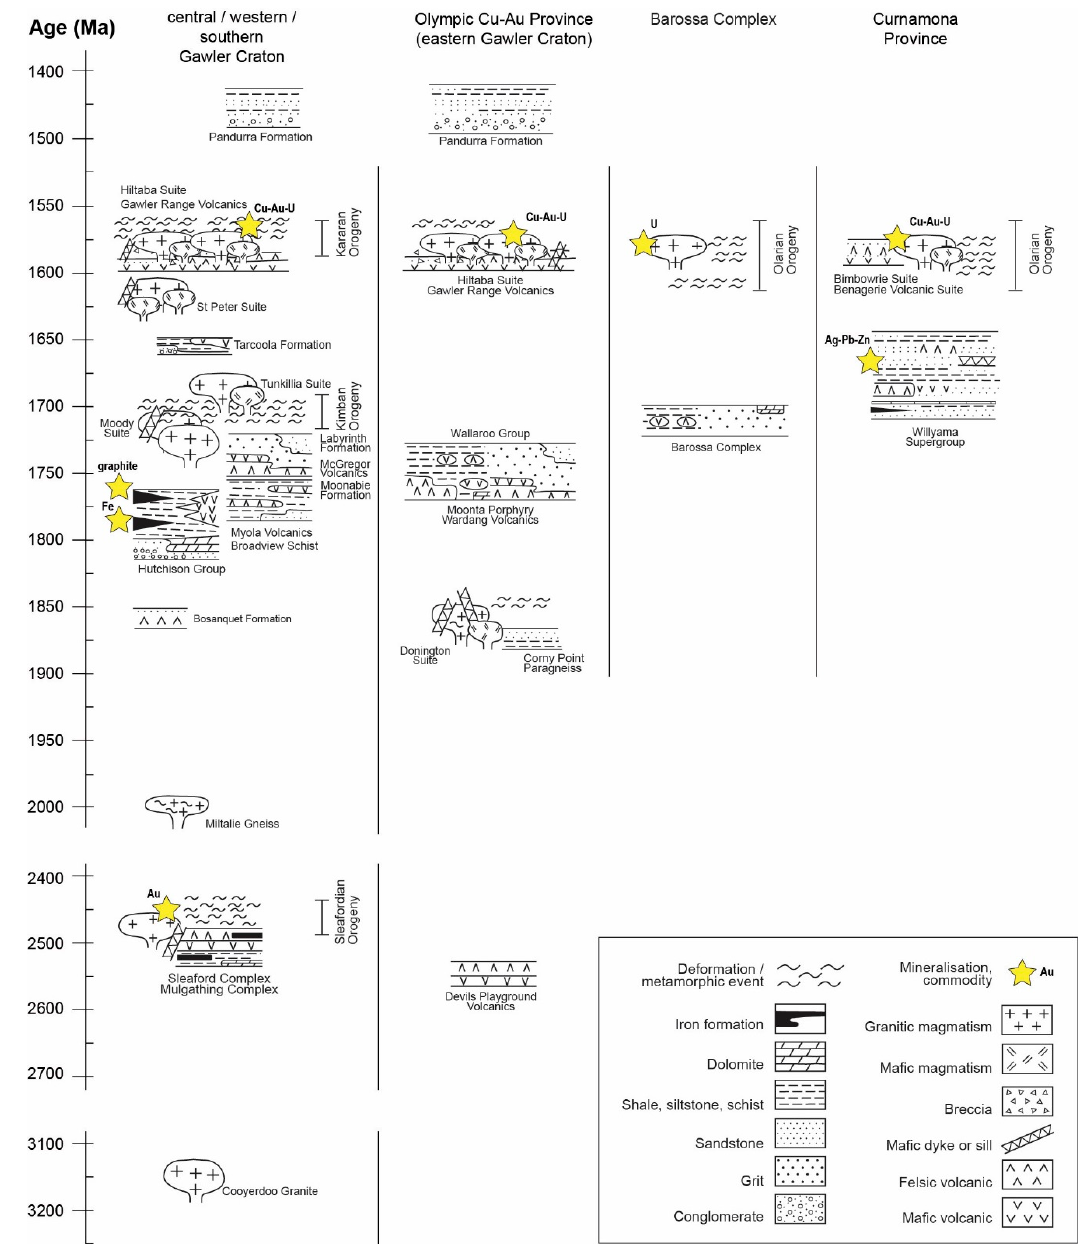
Figure 2. Simplified time-space diagram illustrating the main lithotectonic elements of the Gawler Craton, Barossa Complex and Curnamona Province. This figure also highlights some of the lithotectonic differences between the eastern and western Gawler Craton, with the region of the Olympic Cu-Au Province broadly equivalent to the eastern Gawler Craton. For discussion see [80]. Early Cambrian extension in the southern region of the Adelaide Rift Complex led to formation of a deep basin, the Kanmantoo Trough, likely as a related to back-arc extension inboard of a Cambrian subduction system [81,82]. Deposition was terminated by the Delamerian Orogeny at ca. 510–480 Ma, which resulted in regional-scale fold-thrust systems, variable degrees of high temperature-low pressure metamorphism and extensive granite intrusion particularly in the south [83,84]. While the central axis and eastern regions of the Adelaide Rift Complex was affected by the Delamerian Orogeny, sedimentary units of the Stuart Shelf remained largely undisturbed, likely shielded by rigid Gawler Craton lithosphere during regional compression [82].